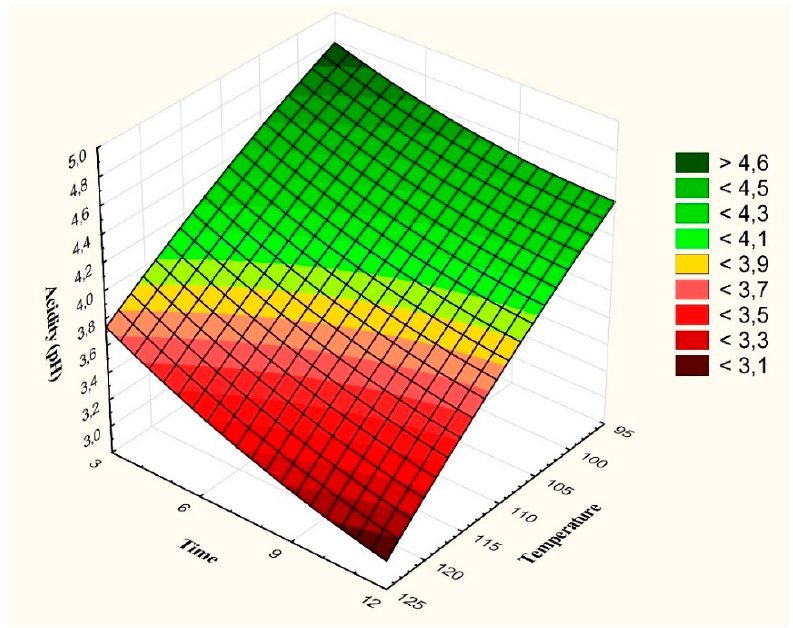
Figure 2. Correlation of the pH value of wet alder wood and the temperature of saturated water steam t and the time τ . The light white-gray color of alder wood with a yellowish tinge of untreated wood was identified in the color space CIE L*a*b* with values on the luminance coordinate L 0 * = 78.3 ± 2.3 and color coordinates: a 0 * = 9.2 ± 1.6; b 0 * = 22.6 ± 1.2. The measured values on the color coordinates of untreated alder wood are comparable with the values reported pre- viously by other authors [14,35,36].